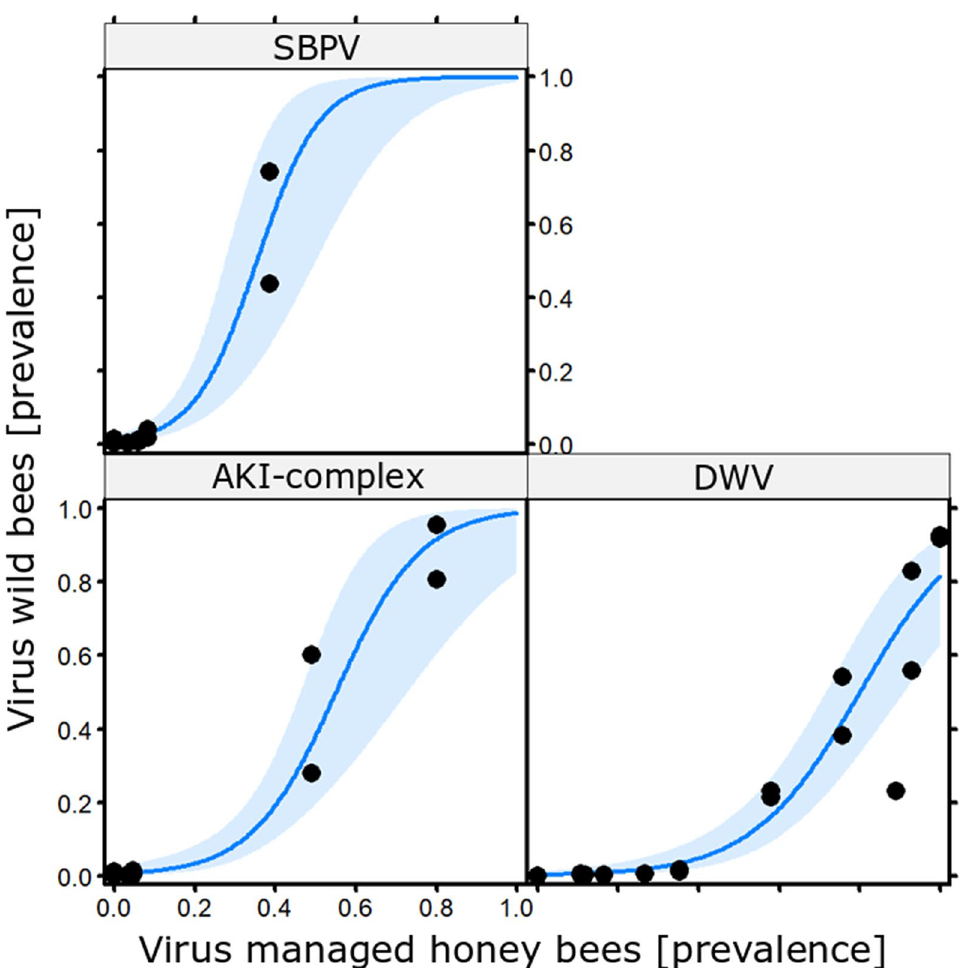
Figure 2. Relationship between viral prevalence in managed honey bees and wild bees split by virus. Analysis indicated a strong relation between the viral prevalence in honey bees and wild bees, the slope of the relation differs, however, between the viruses. For both SBPV (top panel) and the AKI-complex (bottom left panel) we see a clear increase in viral prevalence in wild bees as the viral prevalence in managed honey bees increases. For DWV (bottom right panel) we see a similar relation, yet only when the viral prevalence in honey bees increases above 50%. Shaded blue indicates the 95% confidential